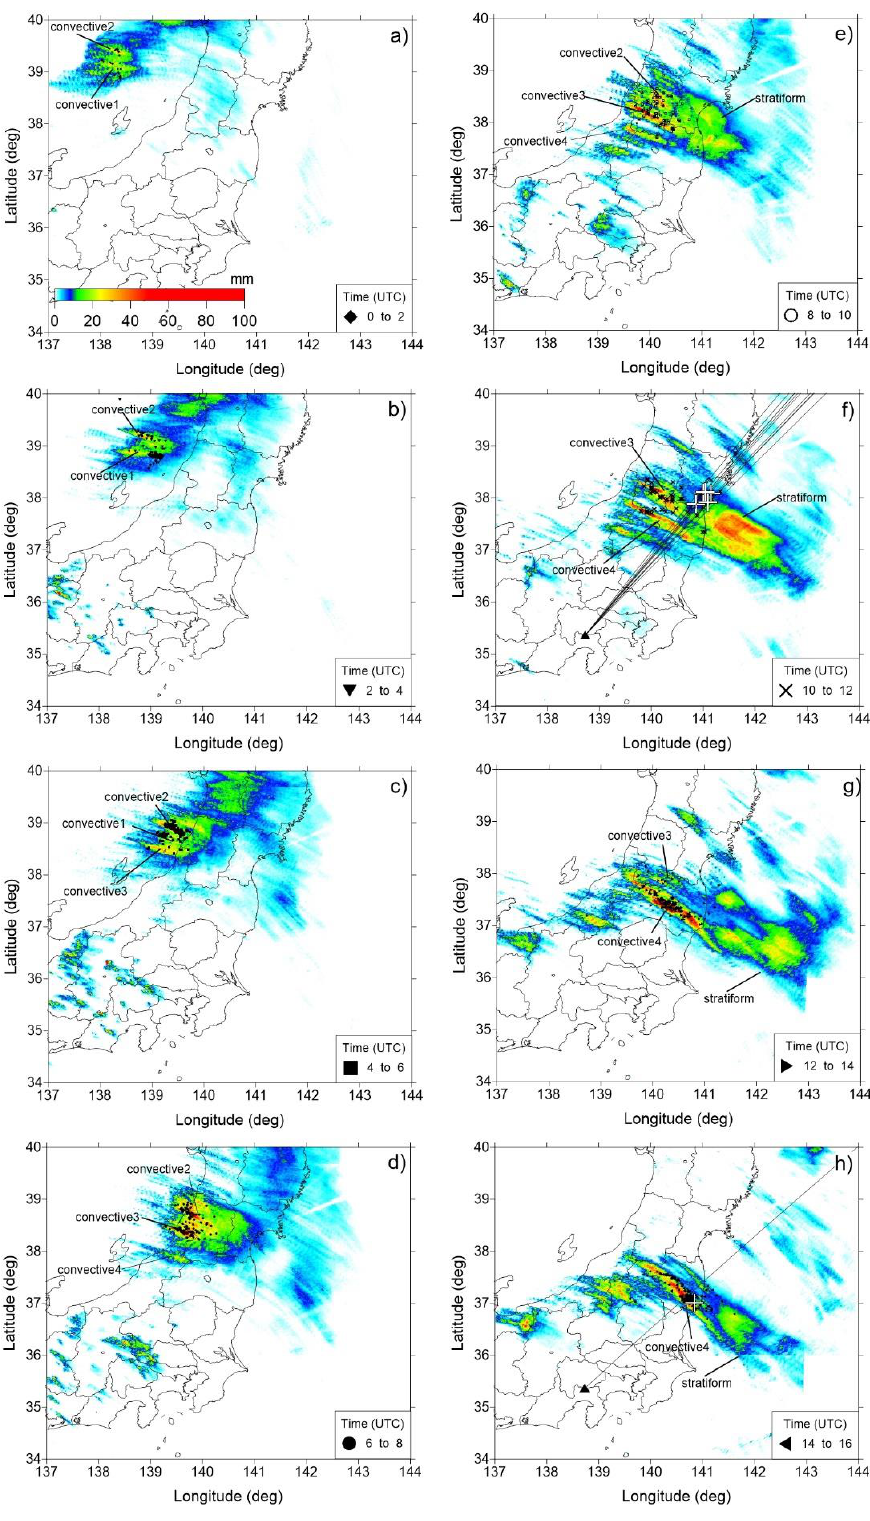
Figure 4. ( a – h ) The time series of precipitation integrated in the sprite-parent MCS and the locations of CGs. The steps in the evolution of the parent thunderstorm system were denoted by the total precipitation every two hours. CGs are indicated by black markers (viz., the lower right legend in each panel). The large white crosses are the sprite-producing +CGs. The convective and stratiform regions are indicated by the words “convective” and “stratiform.” The solid lines from Mt. Fuji are the azimuthal positions of the sprite elements.